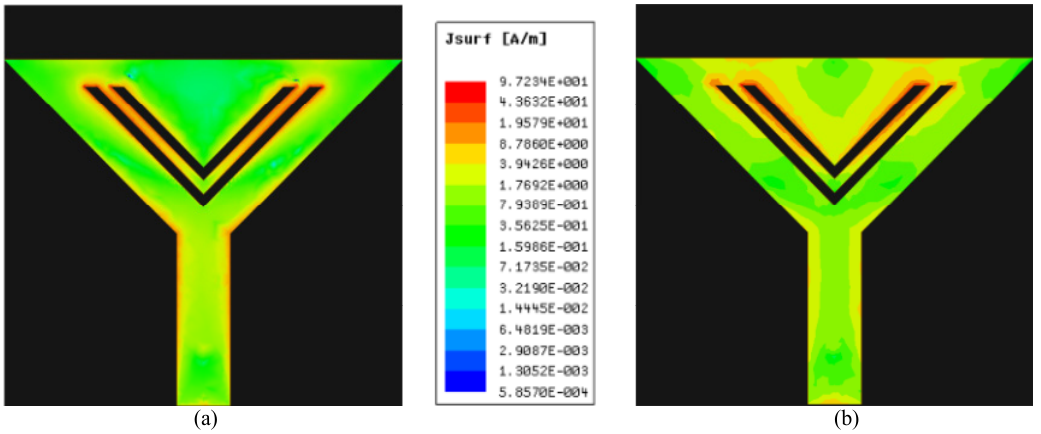
Figure 4. Current distribution of proposed antenna at notch-band of: ( a ) 2.82 GHz ( b ) 3.64 GHz.